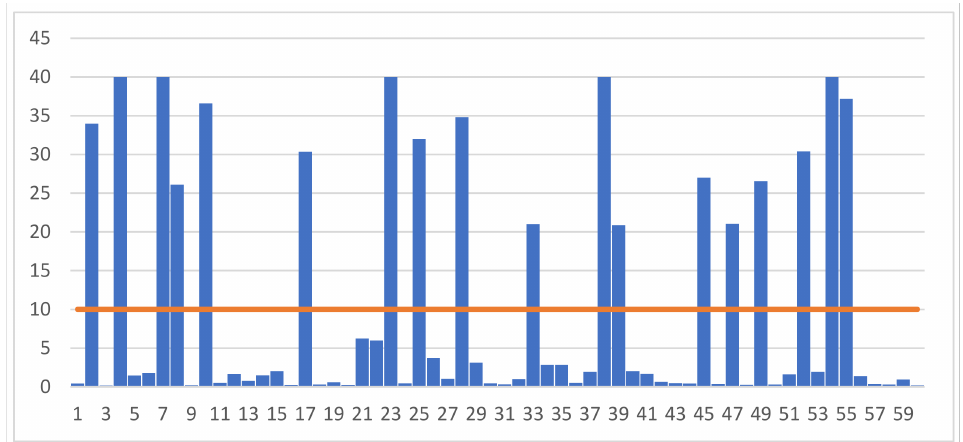
Figure 1. Individual results of measuring the concentration of progesterone (P4) (ng/mL) in the blood of the examined gilts.